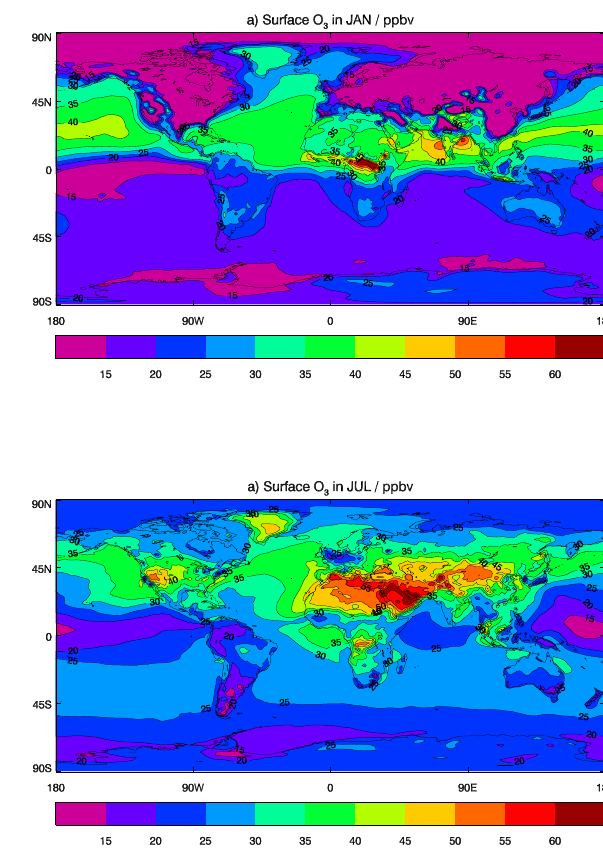
Fig. 22. Multi-annual zonal and diurnal mean OH distributions from the StdTrop chemistry scheme in the tropospheric configuration of the UKCA model in (a) January and (b) July. The thick dashed lines mark the position of the modelled tropopause (Hoerling et al., 1993).